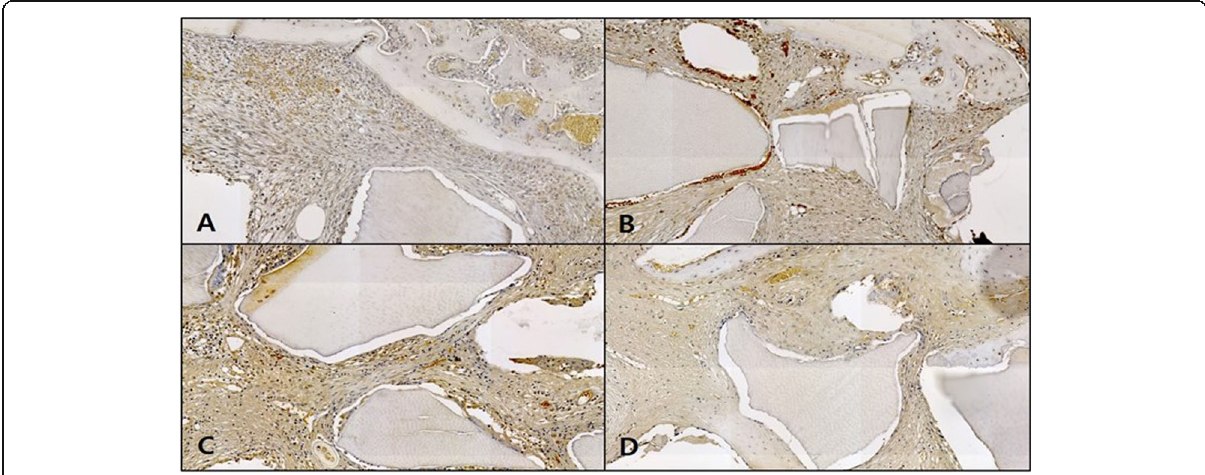
Fig. 15 Microphotograph at 1 week ( A ), 2 weeks ( B ), 4 weeks ( C ), and 6 weeks ( D ) after bone graft with organic matter removed particulate autogenous tooth and type 1 collagen in experimental rabbit. Osteocalcin.